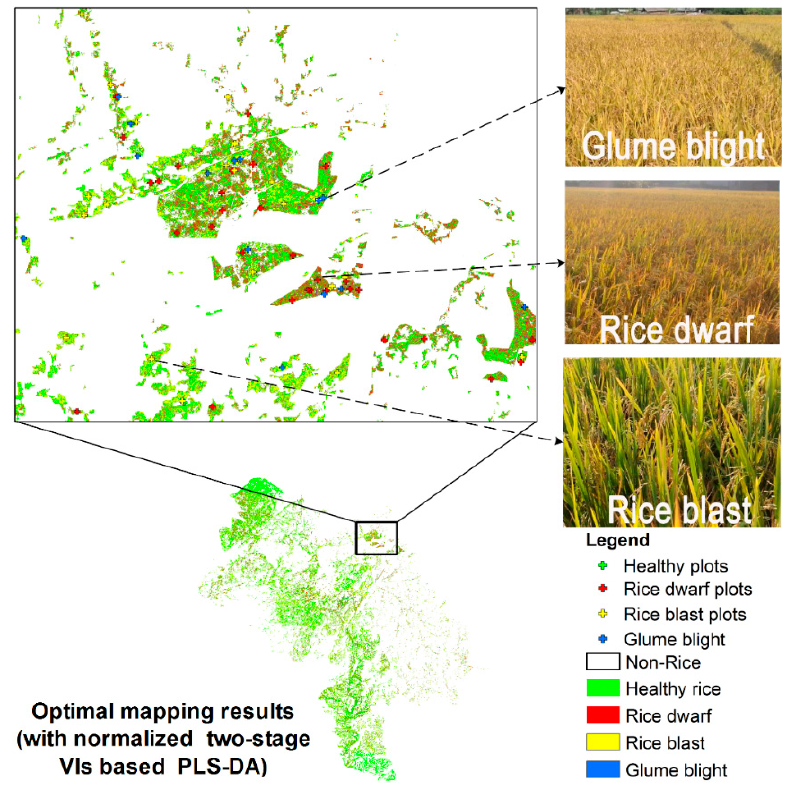
Figure 6. Mapping results of rice diseases in a sub-region based on the optimal normalized two-stage VIs based PLS-DA.